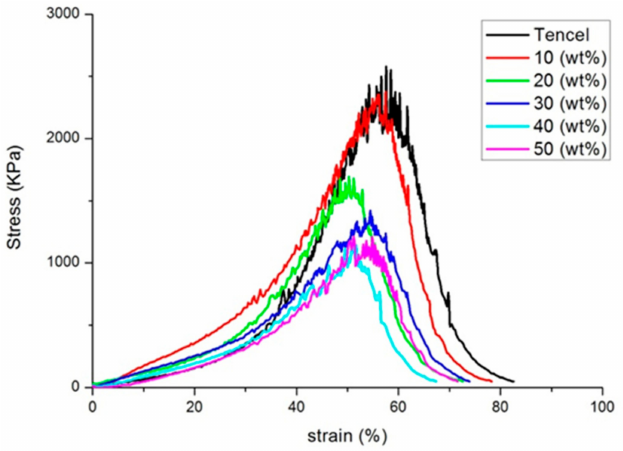
Figure 3. Tensile stress-strain curves of PT nonwoven composites as related to the content of poly- acrylate